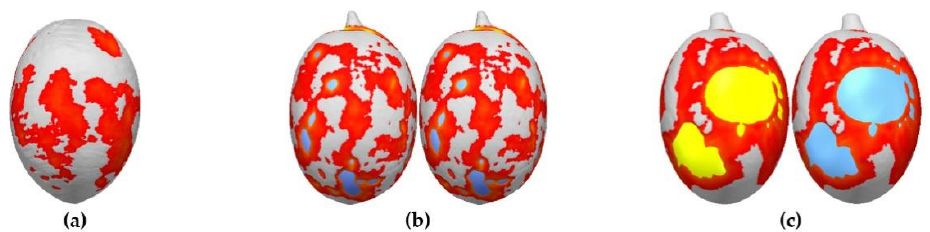
Figure 23. Damage to Hojiblanca variety olives: ( a ) the olives with manual harvesting, ( b ) the olives with mechanical harvesting, and ( c ) the diseased olives.